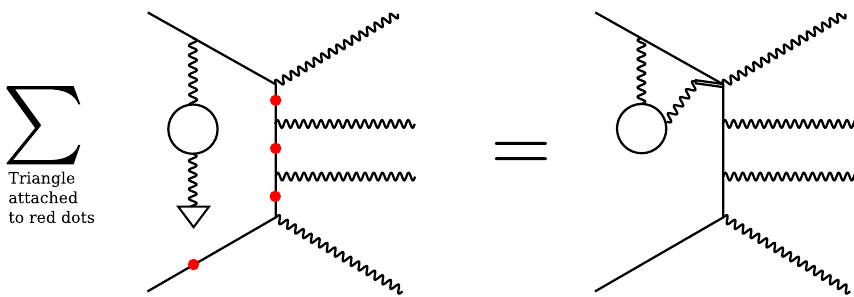
Figure 7. Ward identity for factoring out collinear divergences when l k p 1 , which relies on the leading-order approximation that the photon polarization is longitudinal or equivalently,